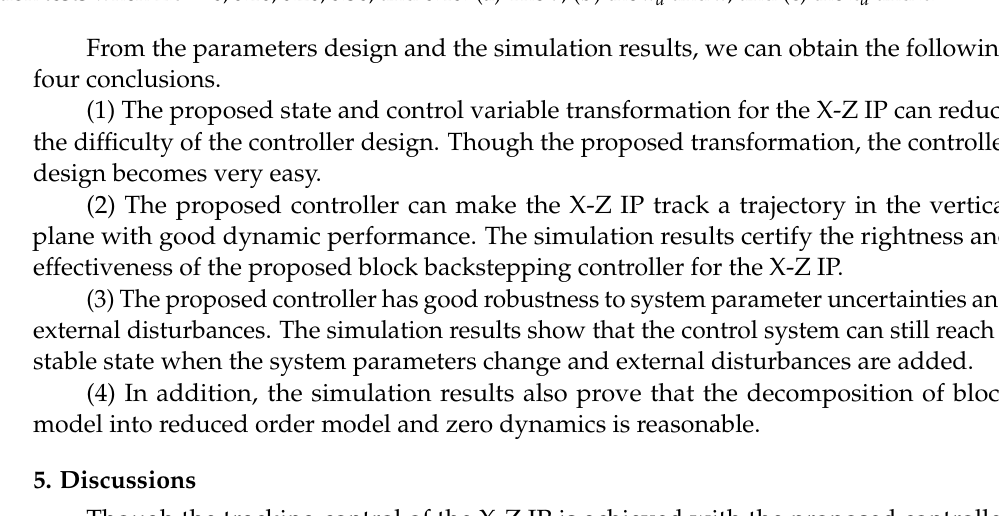
Figure 16. The simulation tests when ∆ z = 0,0.10,0.20,0.30, and 0.40. ( a ) The θ ; ( b ) the x d and x ; and ( c ) the z d and z